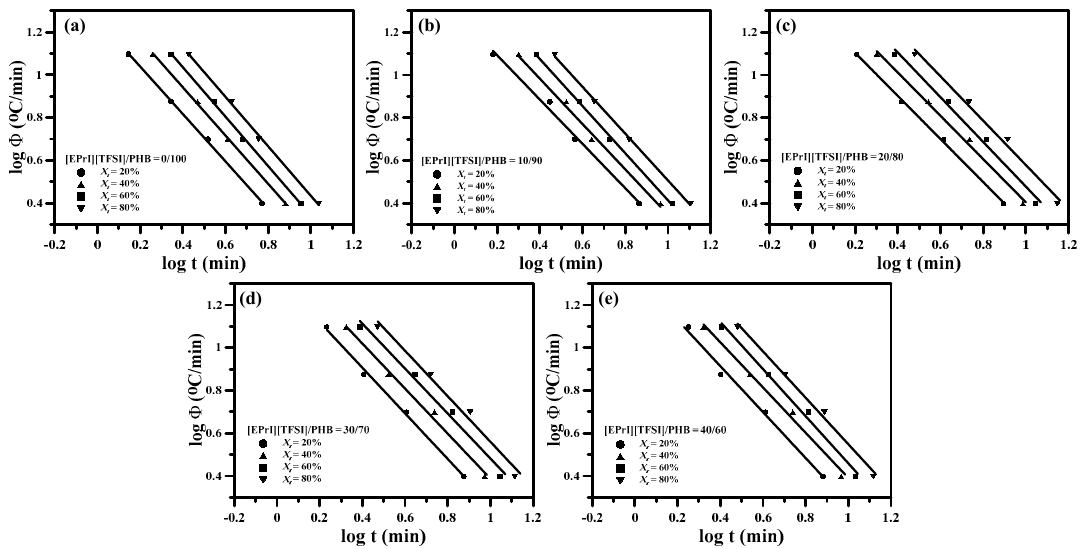
Figure 9. Mo model plots of log Φ -v.s.-log( t ) for non-isothermal crystallization of [EPrI][TFSI]/PHB blends with different composition: ( a ) 0/100; ( b ) 10/90; ( c ) 20/80; ( d ) 30/70; and ( e ) 40/60.